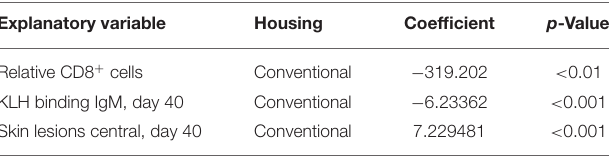
TABLE 5 | Interaction effects with type of housing and explanatory variables with histology score as response variable.